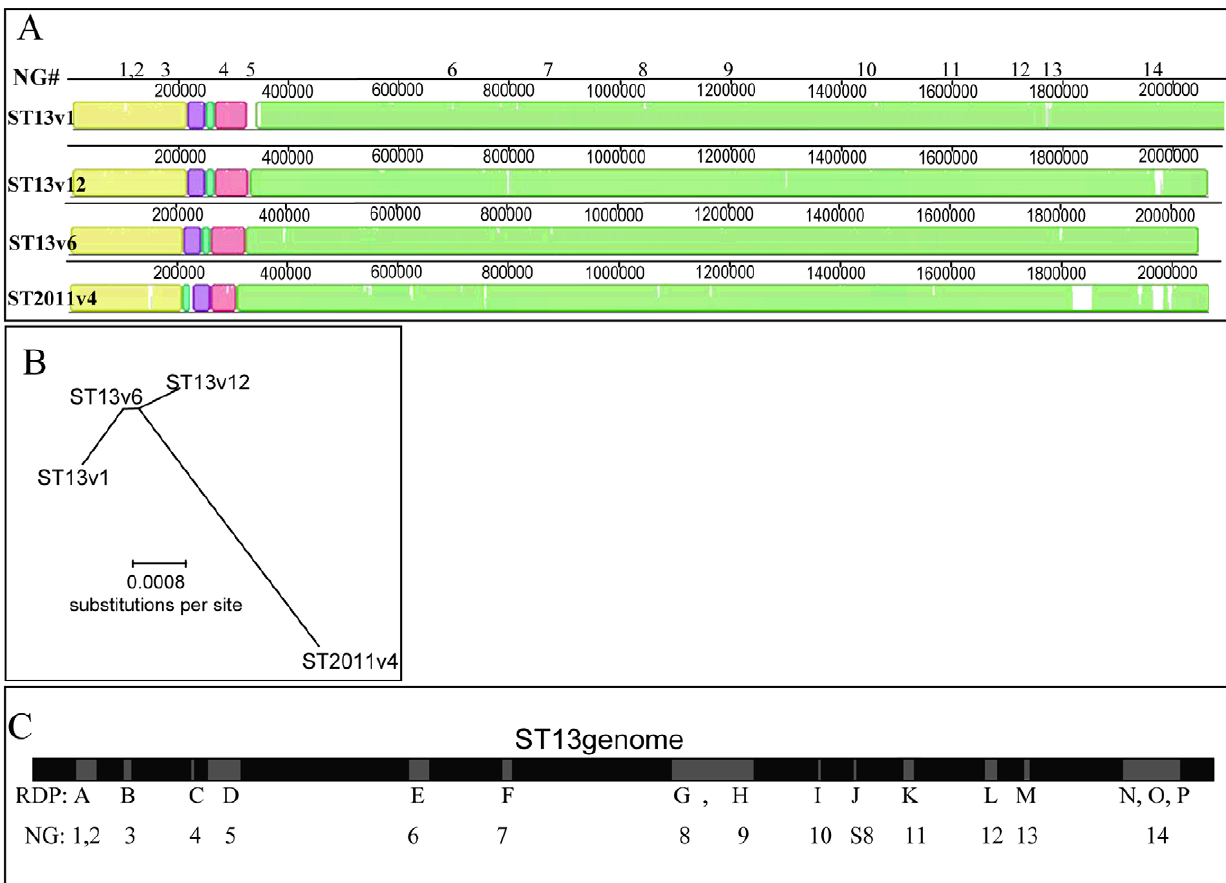
Figure 1. Demonstration of recombination events among Streptococcuspneumoniae genomes isolated from a single patient. (A) MAUVE alignment of the WGSs of four S. pneumoniae isolates showing four distinct strains. Colored blocks highlight regions that are homologous and free from genomic rearrangement. White areas illustrate degrees of average conservation that exist within corresponding genome regions (more white = less conservation). Neighbor group (NG) numbers above the schematic denote the positions of clustered SNP groupings. (B) Maximum likelihood phylogenetic tree (given the best fit model = F84 + G 4 ) expressing the relationship between the four genomes and demonstrating that ST2011v4 is the most divergent of these strains and that differences exist among the ST13 strains. (C) Schematic showing the relative position of recombination events (gray boxes) within the ST13 genome (black), as predicted by RDP3 and NG analyses.